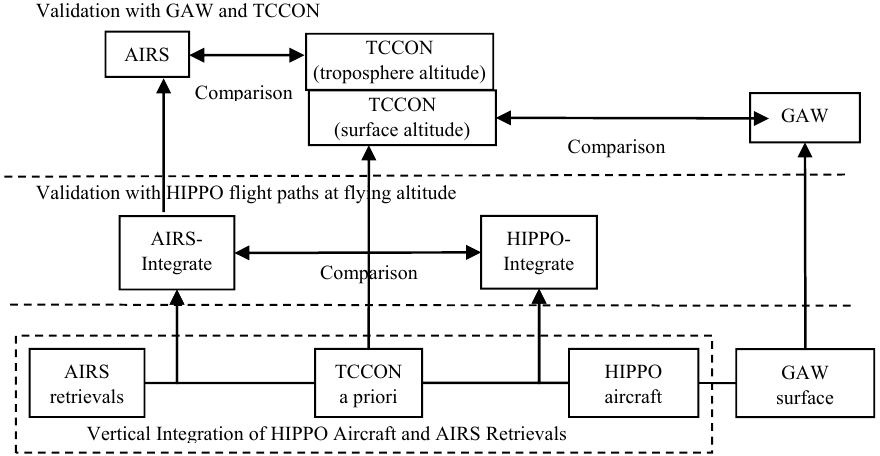
Figure 2. Overall process of spatio-temporal validation of AIRS CO 2 observation.